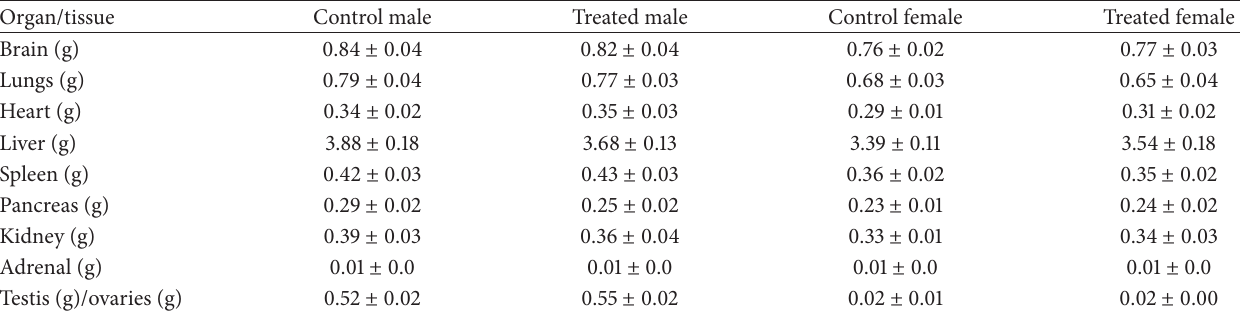
Table 3: Relative organ/tissue weights of male and female